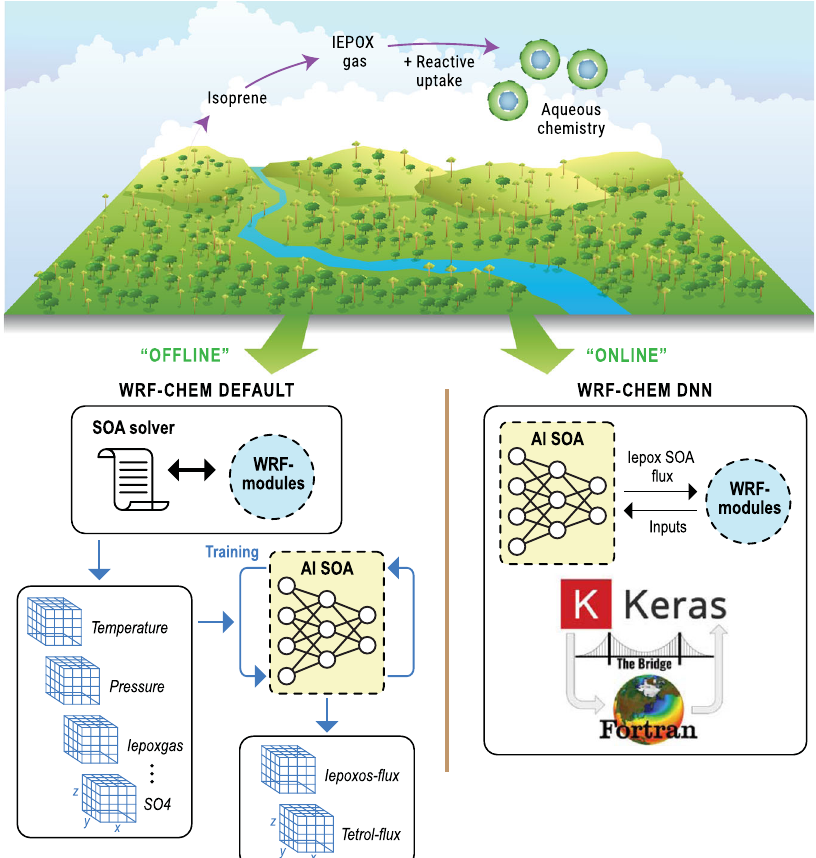
Fig. 1 Schematic illustrating the simulation of IEPOX-SOA using the WRF-Chem Default model and the WRF-Chem DNN model. The default WRF-Chem model is used to generate training data over a 7 h timescale, which is used to train the DNN to output IEPOX-SOA fl uxes over each of the WRF-Chem chemistry timesteps (5 min). The trained DNN is then embedded in WRF-Chem to replace the default IEPOX-SOA solver and used to simulate IEPOX-SOA over 6